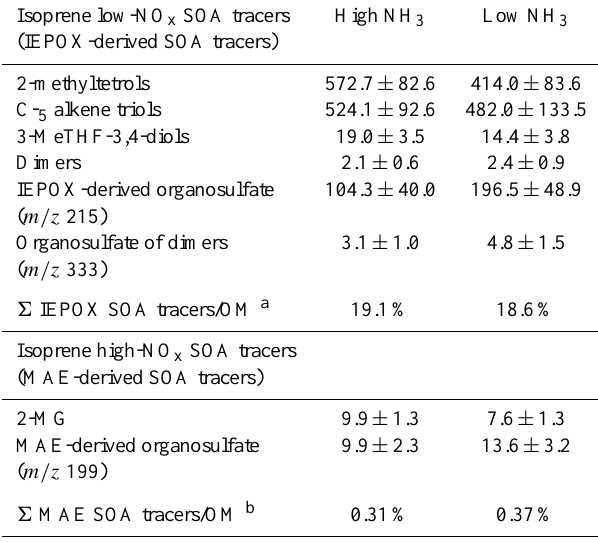
Table 3. Isoprene SOA tracers quantified in PM 2 . 5 samples (ngm − 3 ) collected under high- and low-NH 3